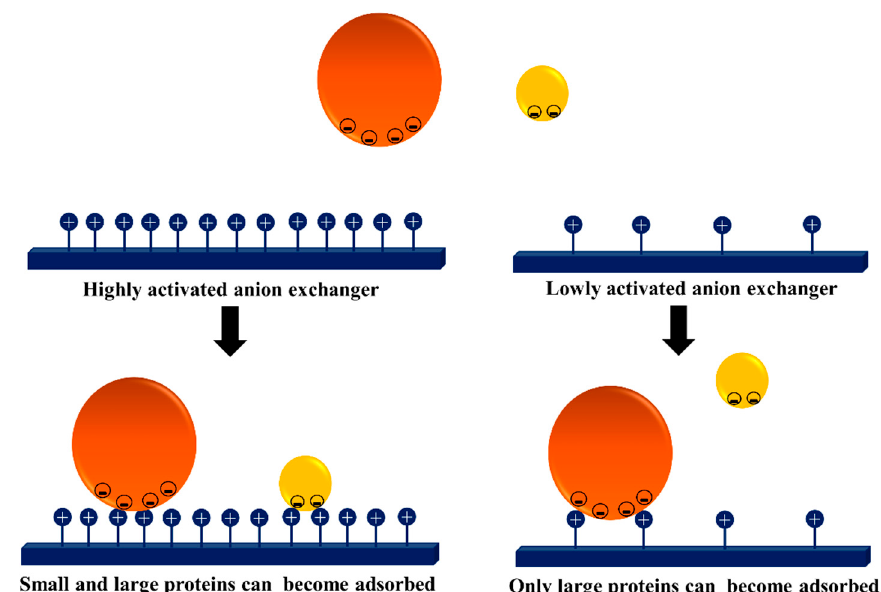
Catalysts 2019 , 9 , x FOR PEER REVIEW Figure 22. Selective adsorption of large proteins in lowly activated ion exchangers.